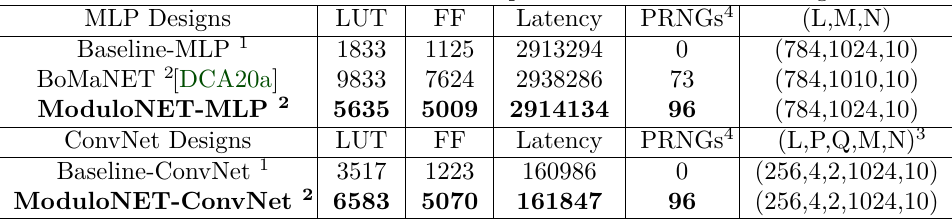
Table 2: Area and Performance Comparison of ModuloNET